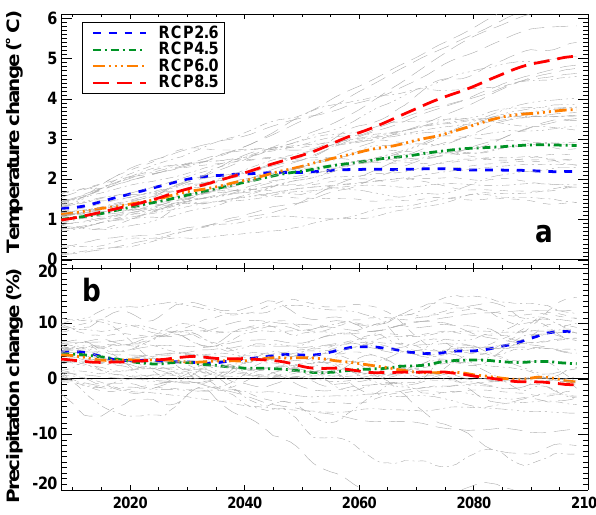
Fig. 2. Projected changes in (a) annual mean air temperature, and (b) annual precipitation sums relative to the period 1961–1990 for 35 GCMs (thin lines). Bold lines and colours indicate the average of GCM ensembles forced with the same RCP. All series are 20-yr low-pass